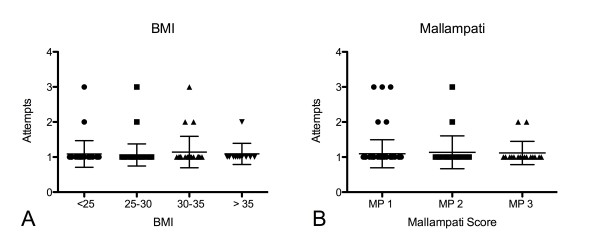
No significant correlation between the number of attempts and the BMI (P = 0.70) (Figure 2A) or the Mallampati score (P = 0.69) (Figure 2B) could be shown. Data are presented as means ± standard deviation.